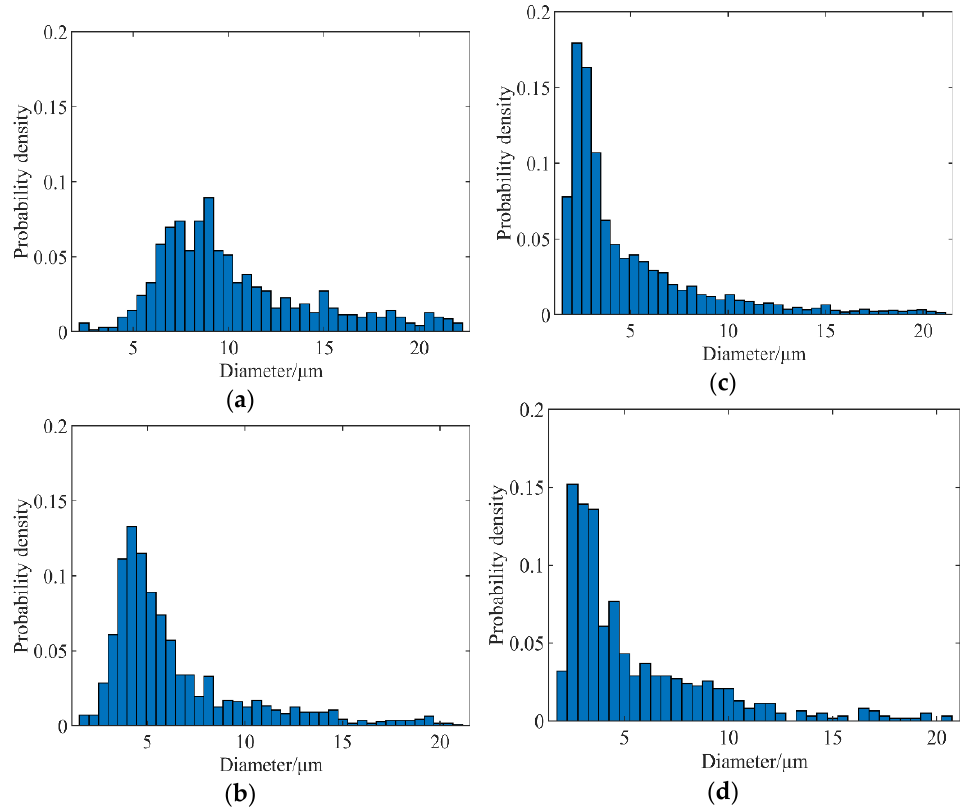
Figure 4. Comparison of droplet probability density distributions in different cases. ( a ) Case 1, ( b ) Case 2, ( c ) Case 3, ( d ) Result in Shinjo and Umemura [4].